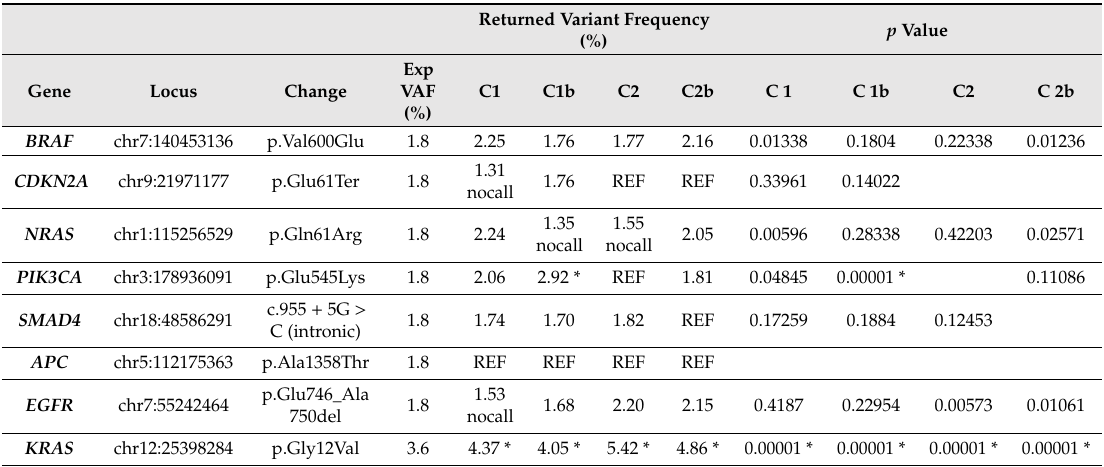
Table 2. Results of the analysis performed by Ion Reporter for the expected variants in cell MIX C at the lowest VAF